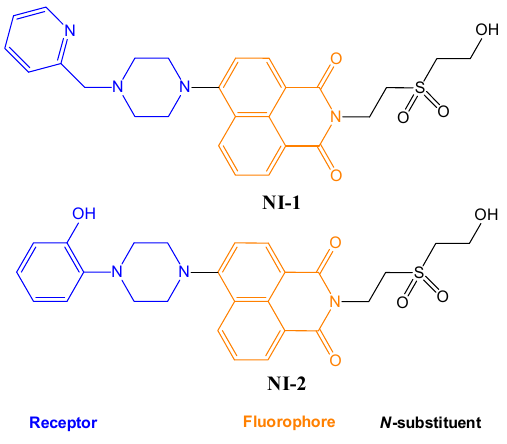
Figure 1. Structures of NI-1 and NI-2 .